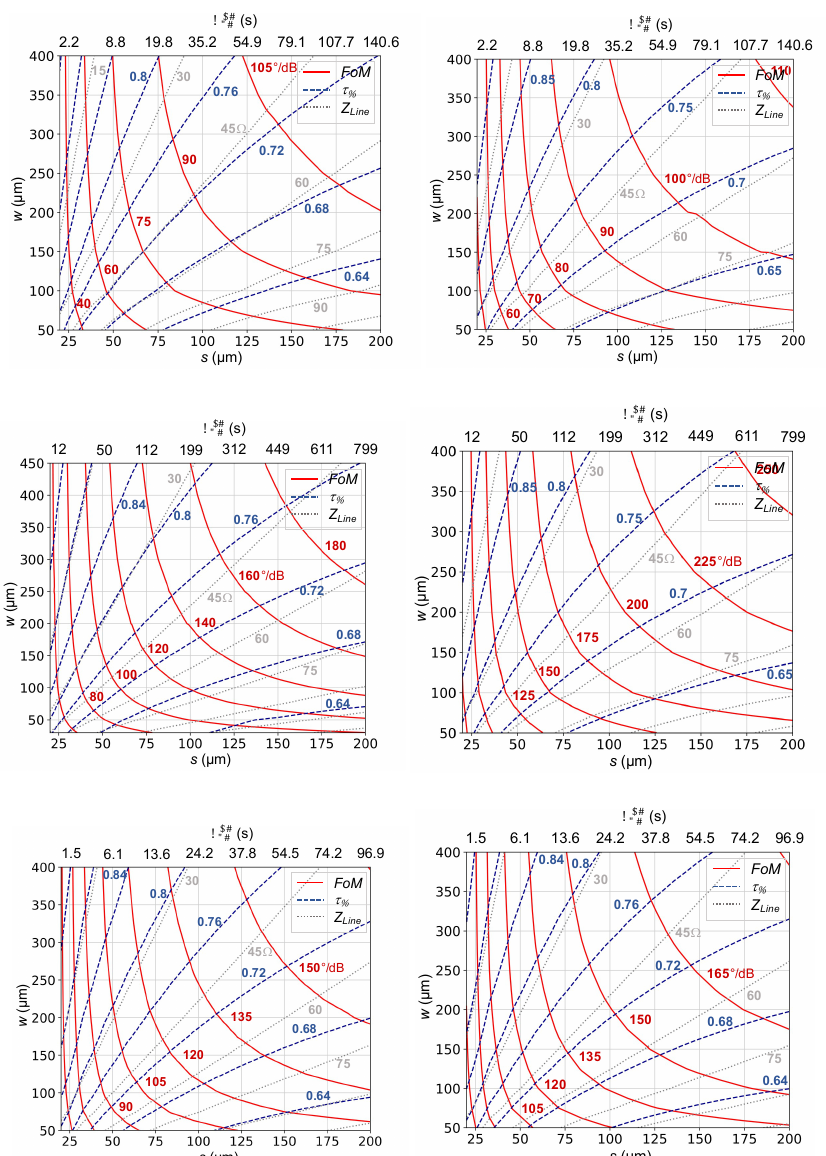
Figure 18. Plots for designing an IMSL phase shifter filled with first-generation LC GT3-23001 ( above ), with second-generation LC TUD-566 ( middle ) and third-generation LC GT7-29001 ( below ) for 30 GHz ( left ) and 60 GHz ( right ), respectively. As the top substrate, use is made of fused silica with a height h s = 300 µ m, a relative permittivity of ε r , s = 3.82, and a dielectric loss factor of tan δ s = 5 · 10 − 5 . The electrical conductivity of the metal parts is set to σ = 4 · 10 7 S/m. A pre-orientation of the LC in the propagation direction was chosen. These plots exhibit the curves of a constant phase shifter figure-of-merit (FoM) (full red lines), orientation e ff ectivity τ ϕ (dashed blue lines), and line impedance Z line (dotted gray lines), depending on the strip line width w (vertical axis), the thickness s ≈ h LC (lower horizontal axis), and the 90 to 10% decay time T 90 , which corresponds to the switch-o ff response 10 time (upper horizontal